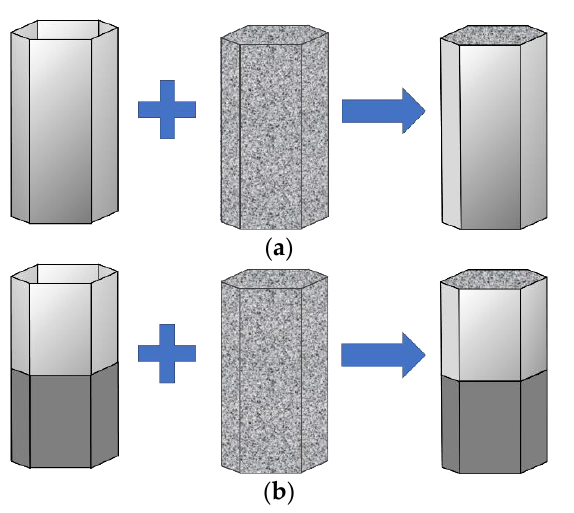
Figure 4. The fabrication process of foam-filled tubes: ( a ) untreated tube; ( b ) local nanocrystal- lized